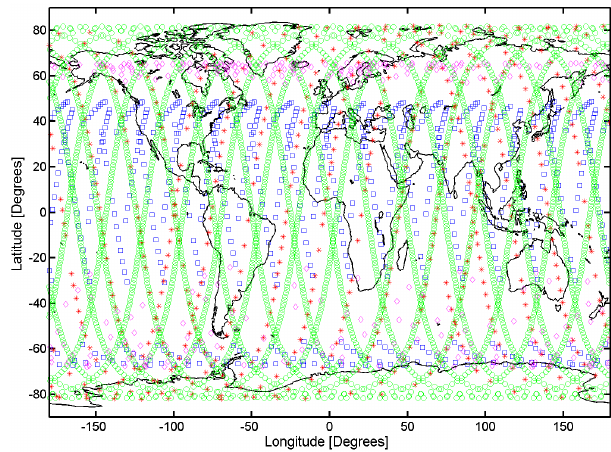
Fig. 2. Spatial coverage of the satellite instruments used. Blue squares indicate HALOE, magenta diamonds indicate ACE- FTS, red stars indicate Odin-SMR, and green circles indicate MLS. HALOE and ACE-FTS measurements are for the month of January 2005. MLS and SMR observations are for the 1 January 2005. QBO [ 1 HCl] t = b + at +